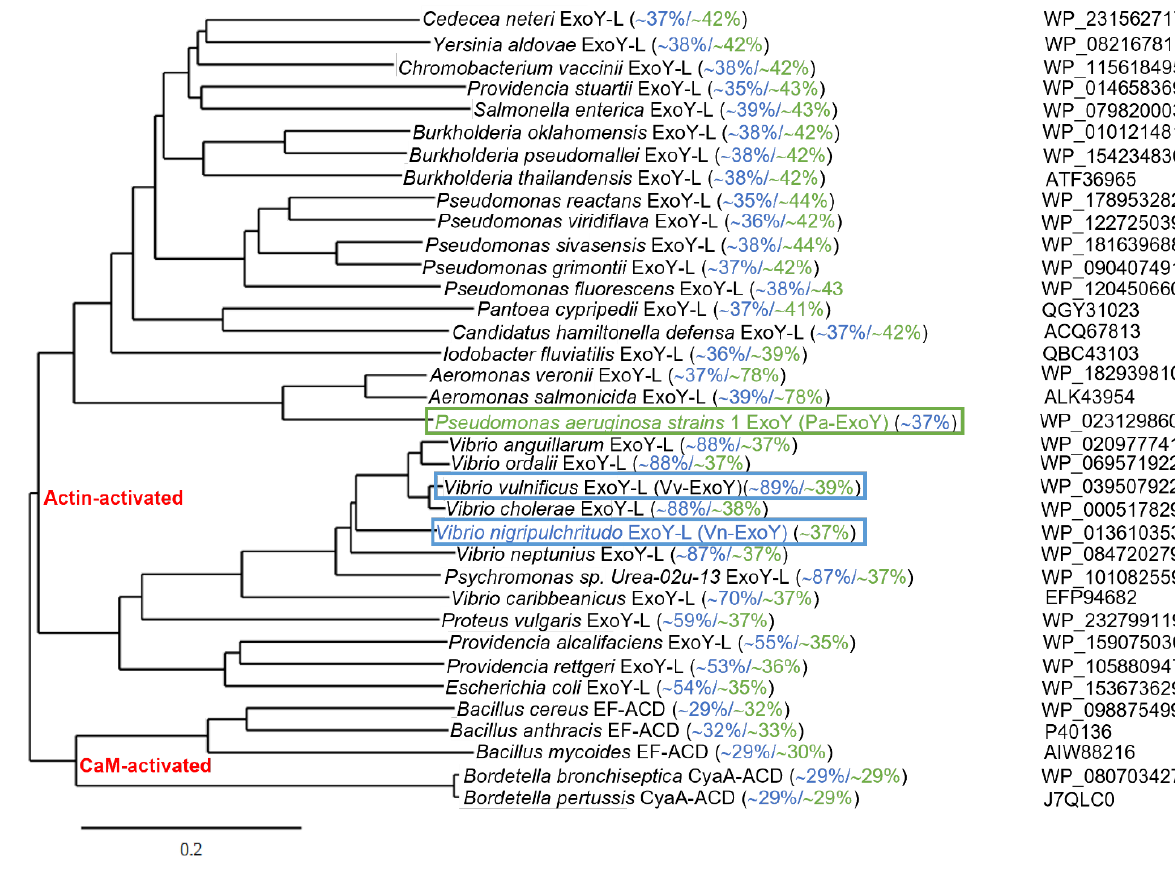
Figure 5. Phylogenetic tree of bacterial nucleotidyl cyclase toxins based on amino acid sequence comparisons. Alignment of the amino acid sequences of Pa -ExoY, Vn-ExoY and ExoY-like pro- teins/modules that are found in other γ - or β -proteobacteria and are potentially activated by actin, CaM-activated CyaA and EF and their homologues potentially activated by CaM, was made with Clustal Omega (using a neighbor-joining clustering method; http://www.ebi.ac.uk, accessed on 1 February 2022) [101]. Phylogenetic tree data obtained with clustal omega was then used to create the phylogenetic tree by using TreeDyn (www.phylogeny.fr) [102]. Pairwise sequence similarities (%) with Pa -ExoY and Vn -ExoY are displayed in green and blue, respectively (Sequence Identity And Similarity (SIAS) tool, http://imed.med.ucm.es/Tools/sias.html accessed on 21 May 2022). F-actin- and G-actin-activated ExoY toxins are framed in green and blue respectively. NCBI accession numbers of protein sequences are indicated on the right.